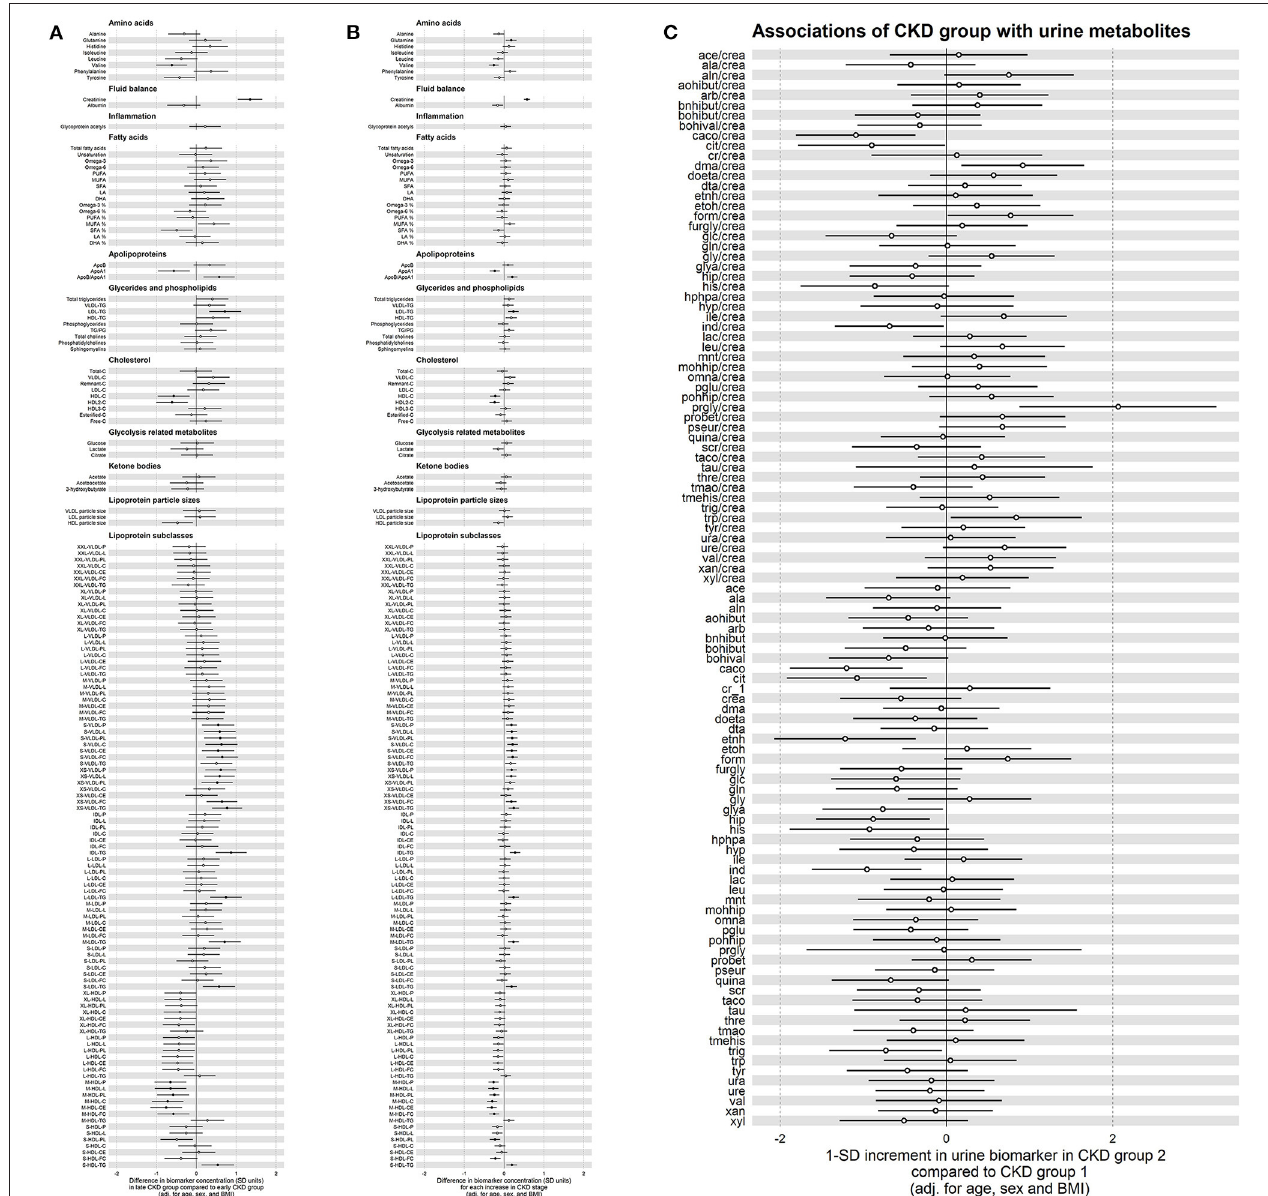
FIGURE 4 | (A) Forest plot comparing plasma metabolite concentrations between late and early chronic kidney disease (CKD) group. Black colored in circle signifies statistical significance. Values to the right of the midline are present in higher concentrations in late compared to early CKD group. Values to the left of the midline are present in lower concentrations in late compared to early CKD group. Model has been adjusted for age, sex and body mass index (BMI). (B) Forest plot comparing plasma metabolite concentrations at each stage of chronic kidney disease (CKD) when compared with the previous stage of CKD. Black colored in circle signifies statistical significance. Values to the right of the midline are present in higher concentrations at each stage of CKD when compared to previous stage. Values to the left of the midline are present in lower concentrations at each stage of CKD when compared to previous CKD stage. Model has been adjusted for age, sex and body mass index (BMI). (C) Forest plot comparing urine metabolite concentrations between late and early chronic kidney disease (CKD) group. White circle signifies no statistical significance. Values to the right of the midline are present in higher concentrations in late compared to early CKD group. Values to the left of the midline are present in lower concentrations in late compared to early CKD group. Model has been adjusted for age, sex and body mass index (BMI).